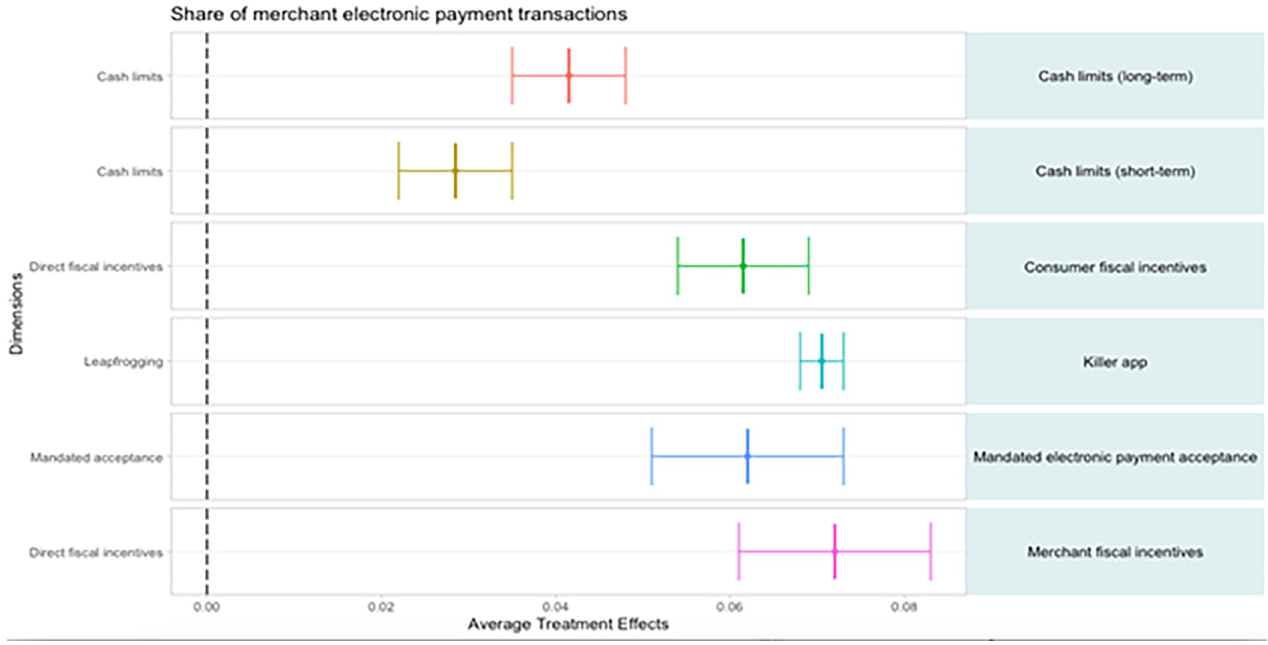
Fig 5. Impact of incentives: Treatment effects on the share of merchant P2B electronic payment transactions (merchant-level sample).